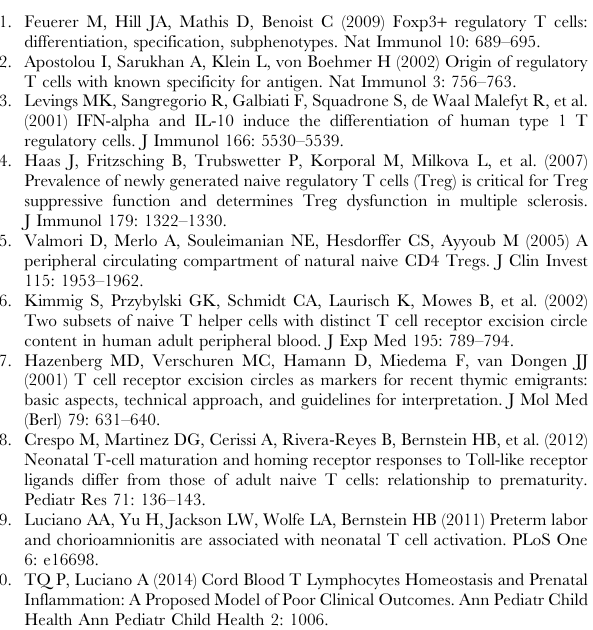
Figure S1 Surface and intranuclear staining for Tregs in fresh cord blood mononuclear cells (CBMCs) and thawed CBMCs. CBMCs were surface stained with fluorochrome labeled mono- clonal antibodies followed by intranuclear staining for FOXP3, fixation and flow cytometric analysis.